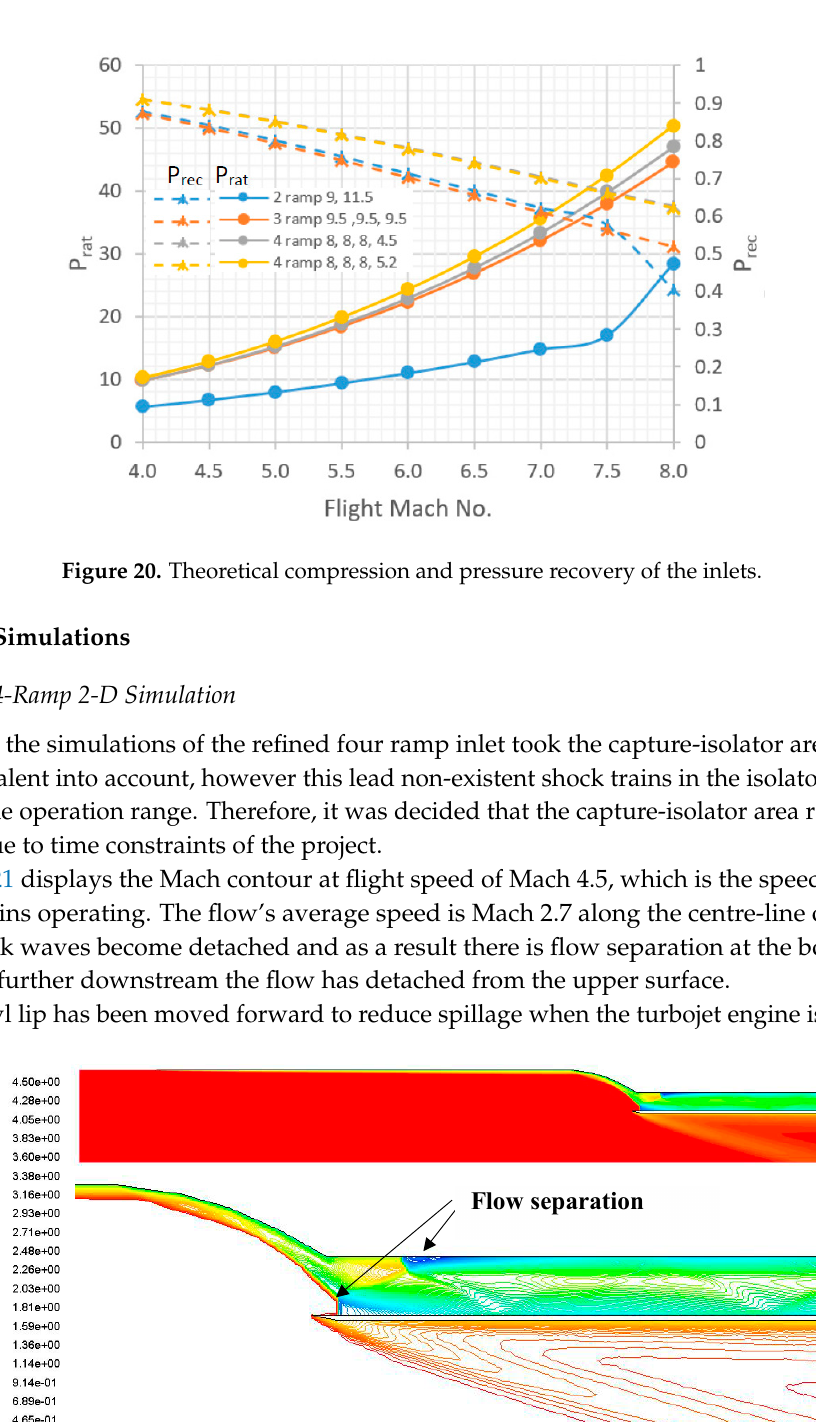
Figure 19. Adiabatic efficiency of inlets for different ramp configurations.